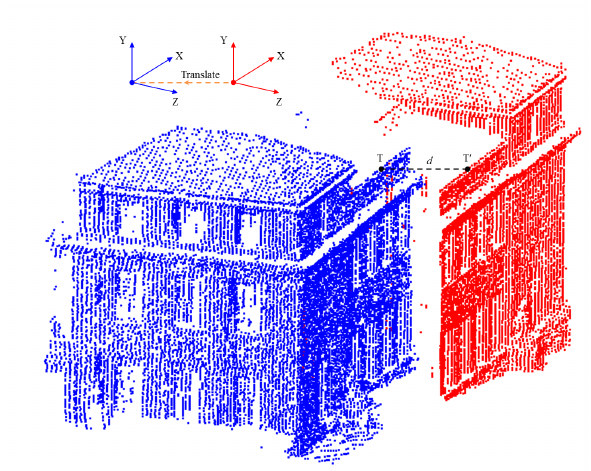
Figure 3: Scanned building with separate scans with the mis- aligned scan needing to be translated through depth d .